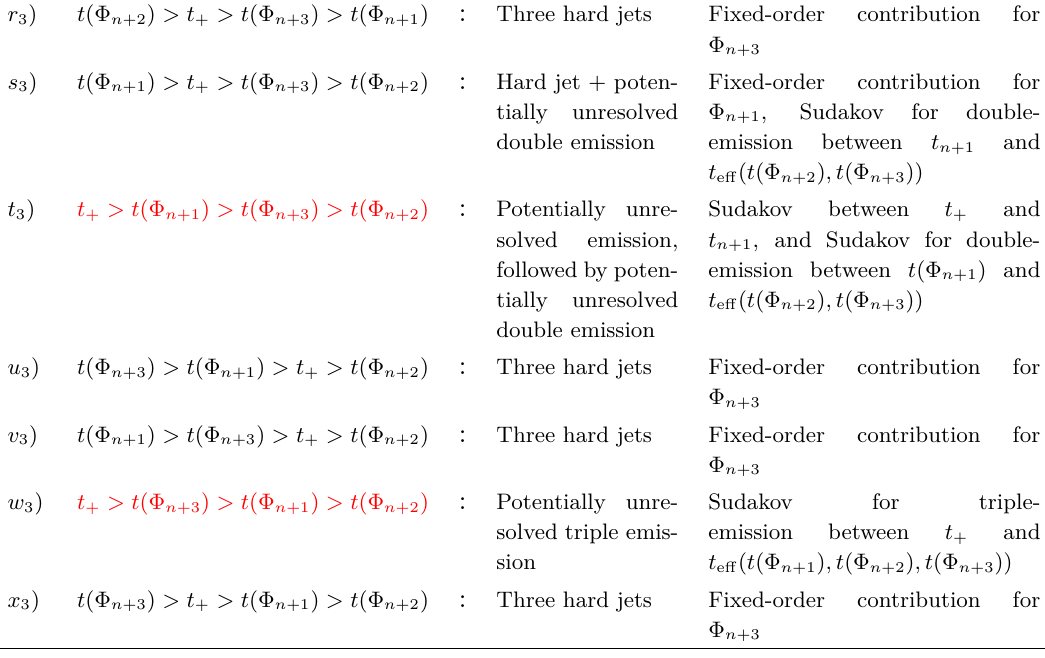
Table 8. Possible evolution variable orderings for three-parton states. For e + e − → jets, only the ordering sequences in red apply, while any ordering is possible for generic hadron-collider